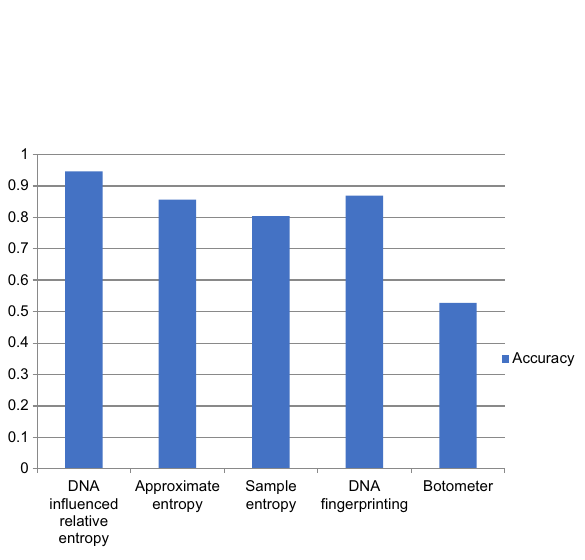
Figure 6. Comparison of Accuracy metric for different state-of-art